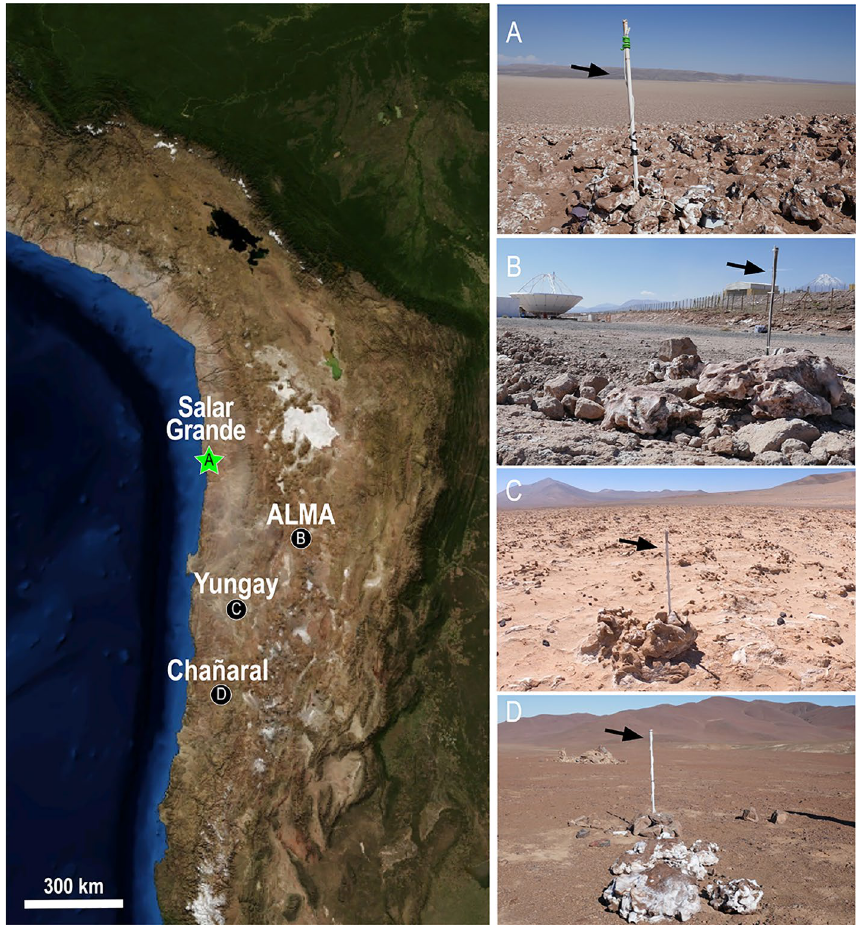
Figure 1. Left Satellite image of part of the Atacama Desert in northern Chile showing the location of field sites, including the control site at Salar Grande where all halite nodules originated ( A ), and the transplant sites at ALMA ( B ), Yungay ( C ), and Chañaral ( D ). Right Photos of each site showing the halite nodules and the environmental sensors deployed 1 m off the ground (black arrows). Additional photos of halite nodules and the sensors installed inside are in Fig.